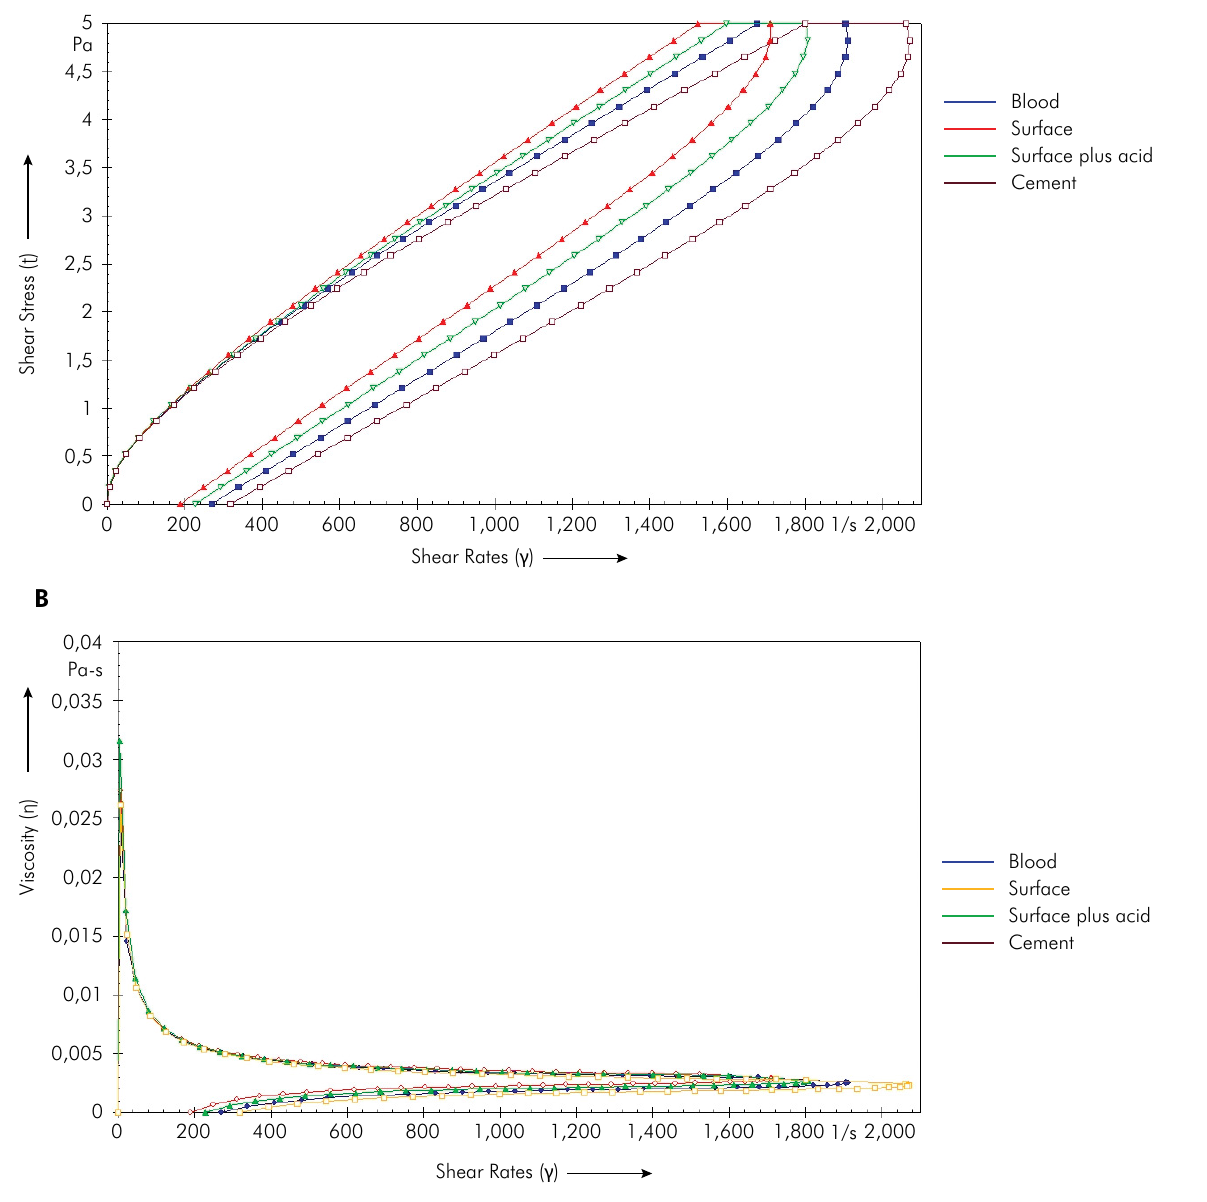
Figure 2. Blood flow (A) and viscosity curves represented by the shear rates (B) under normal conditions and the different treatments. The results are expressed as the median of 6 experiments with different individuals. p >